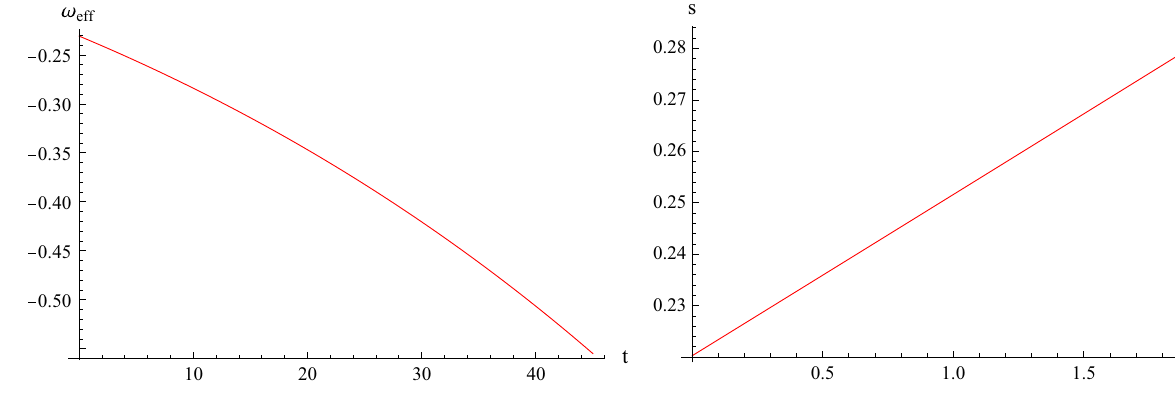
Fig. 7 Plot of ω eff and r – s parameters versus cosmic time t for c 2 = c 3 = 5 . 5 and c 10 = 0 . 005